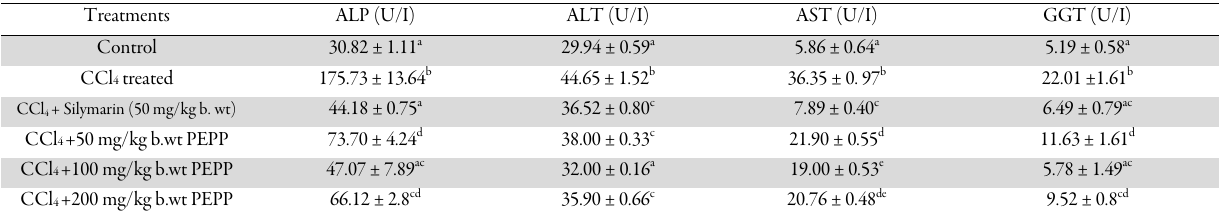
Values are expressed as means of 5 replicates ± SEM. Values with the same superscript along the column are not significantly different (p < 0.05). ALP: alkaline phosphatase; ALT: alanine aminotransferase;AST: aspartate aminotransferase; GGT: gamma glutamyl transferase. Table 3. Effect of PEPP on homogenate activities of liver function enzymes of CCl4-treated hepatotoxic rats Treatments